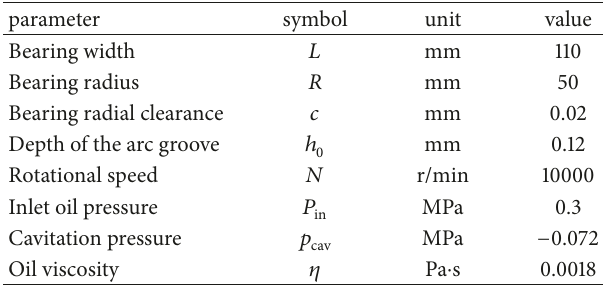
Table 1: Primary parameters of spiral oil wedge sleeve